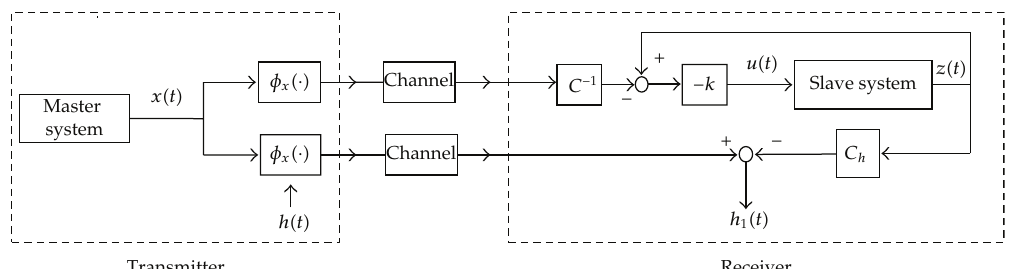
Figure 5: Secure communication